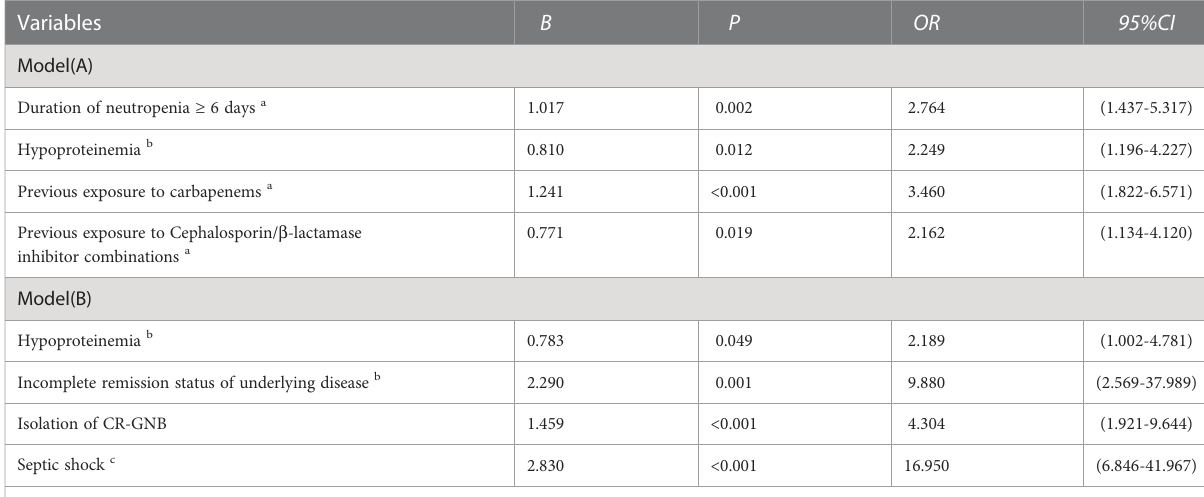
TABLE 3 Multivariate analysis of risk Factors for carbapenem resistance (Model A) and 28-day all-cause mortality (Model B) in patients with hematological diseases suffering from bloodstream infections caused by gram-negative bacteria.